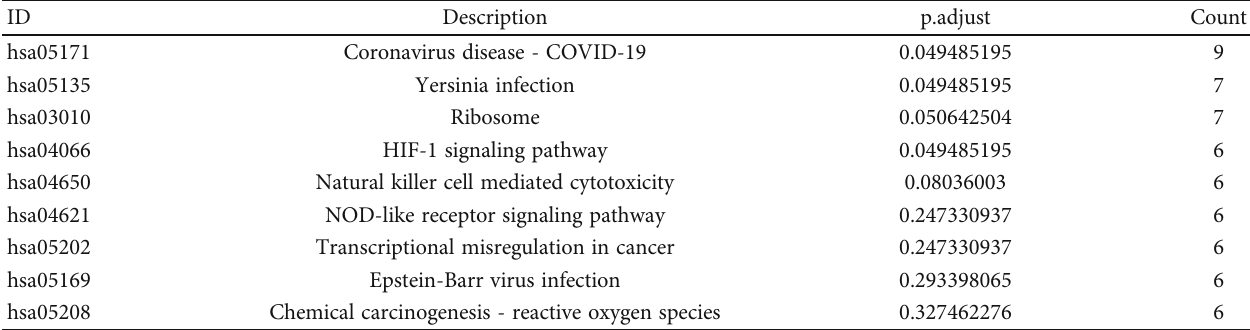
Table 3: The KEGG pathway enrichment analysis of genes in turquoise